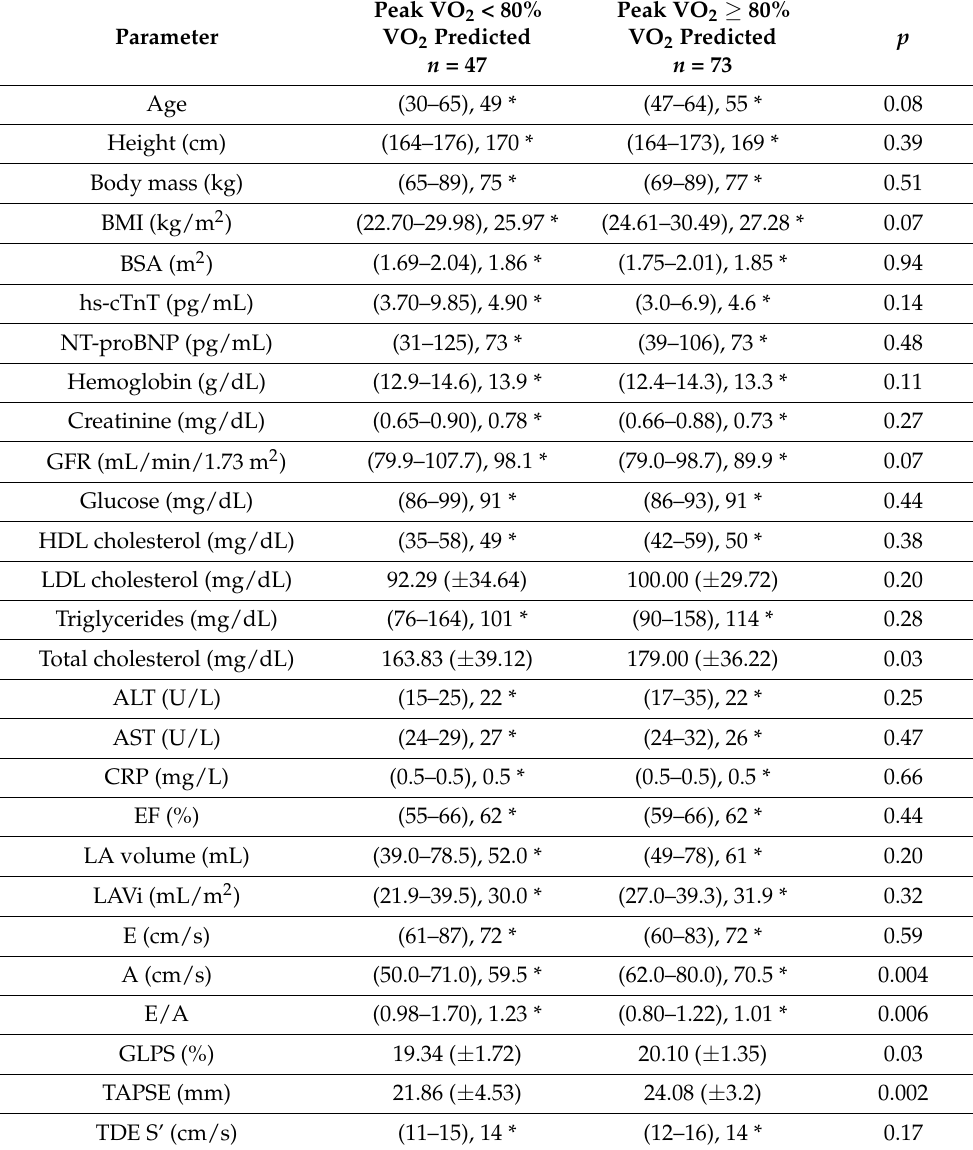
Table 1. Evaluation of basic characteristics, laboratory tests, and echocardiography among the investigated